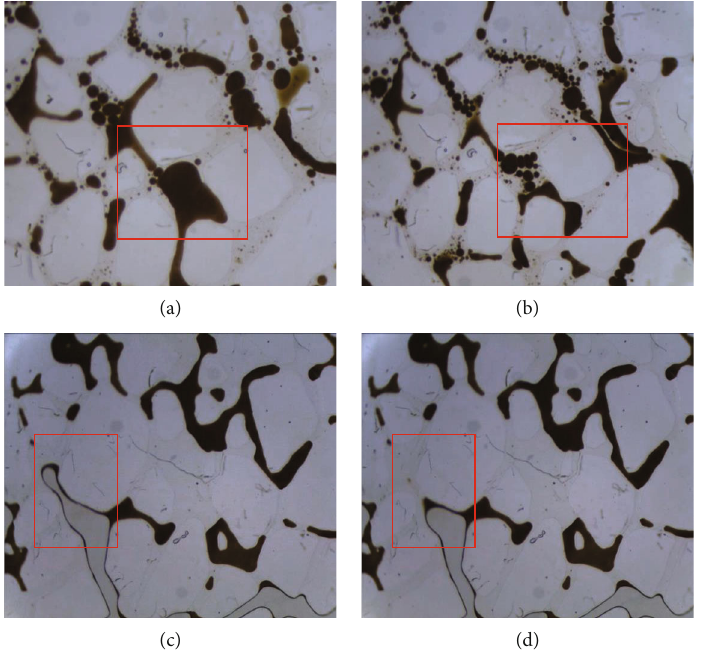
Figure 6: Remaining oil distribution under di ff erent displacement modes: (a) represent large oil block after water fl ooding; (b) represent a few smaller oil droplets after viscosity reducer fl ooding; (c, d) represent the direction of capillary force is consistent with the displacement direction.